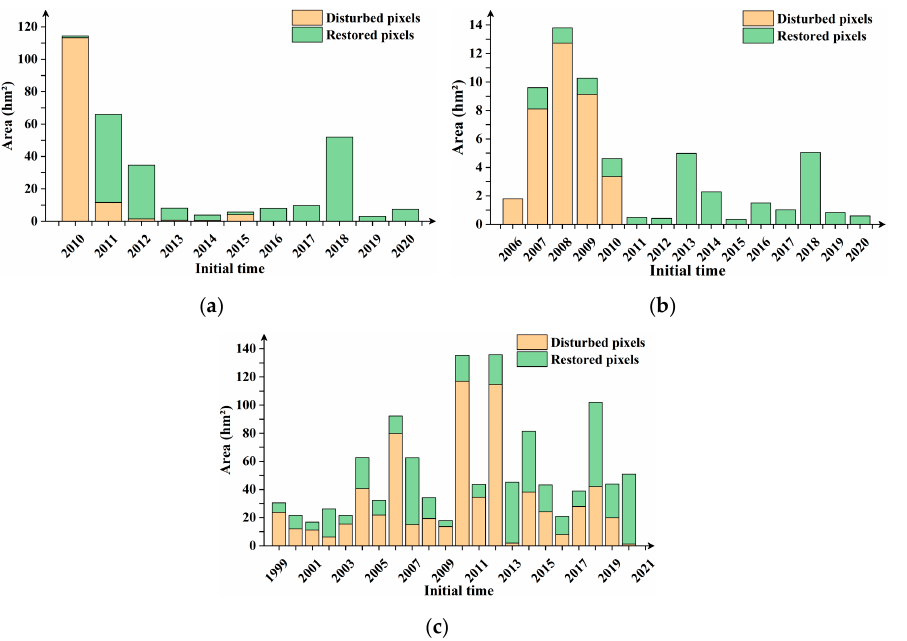
Figure 9. Pixel statistics of disturbance and restoration initial time. ( a ) East site; ( b ) South site; ( c ) North site.